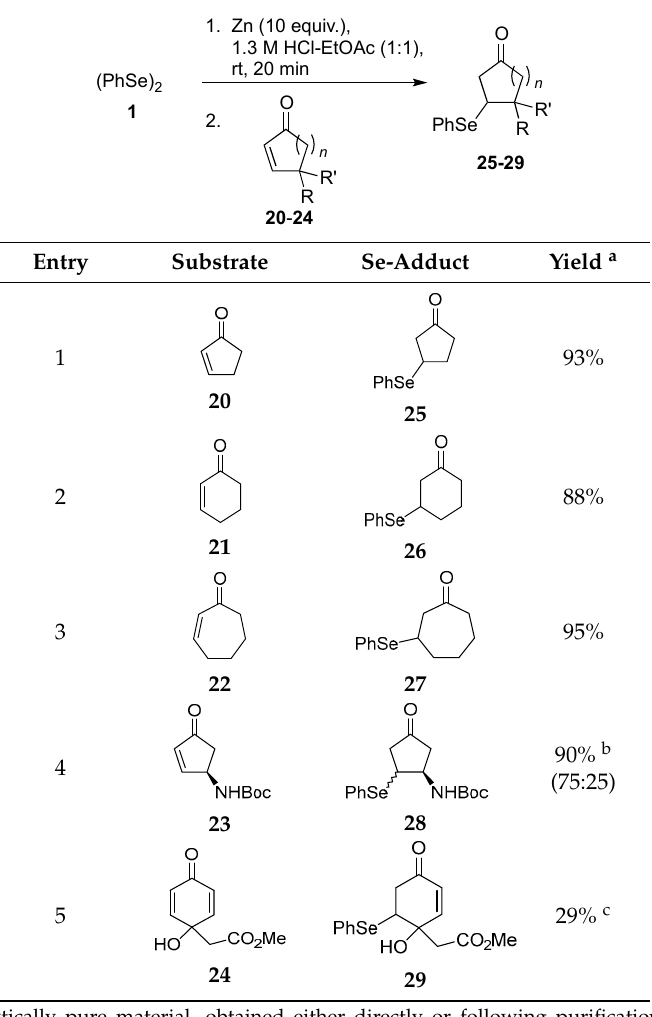
Table 2. Telescoped diselenide reduction-conjugate addition to cyclic enones 20 – 24 .